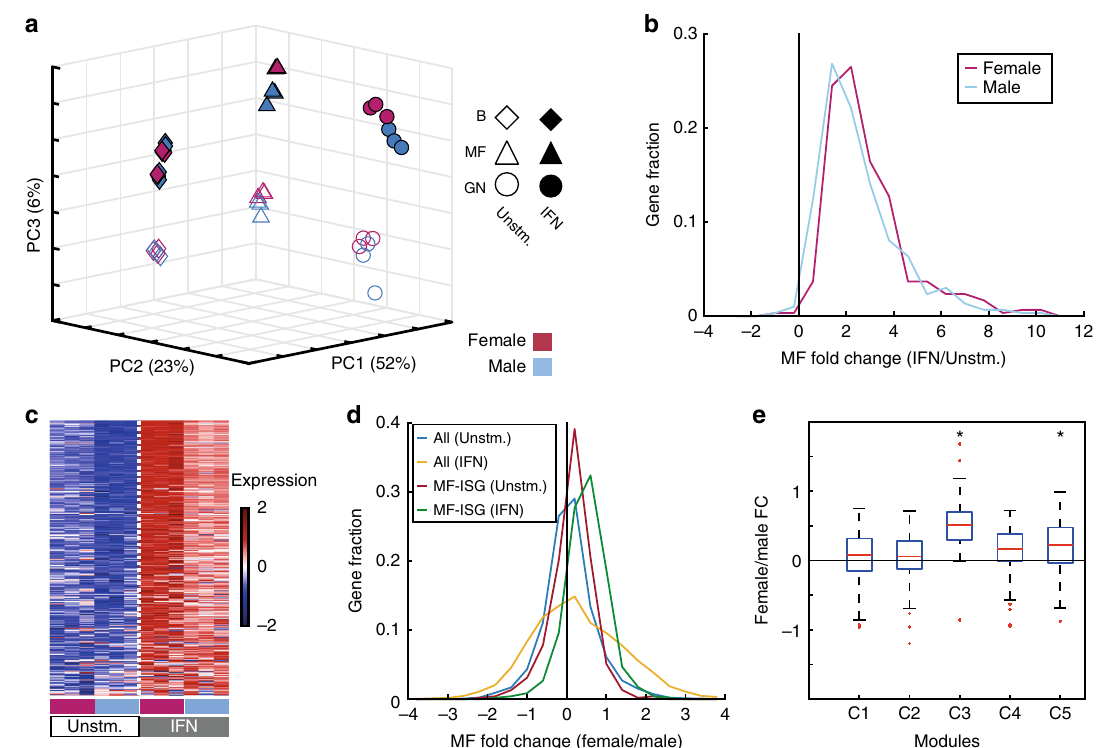
Fig. 4 Interferon boosts the transcriptional sexually differential immune response. a Principal component analysis (PCA) of GN, MF, and B cells (circles, triangles, and diamonds, respectively) of females and males (pink and light blue) with and without IFN ( fi lled or open shapes, respectively), based on 1000 autosomal genes with the highest standard deviation. Axes are the fi rst three principal components (PCs). b The distribution of the log 2 fold change values between IFN-stimulated MF and unstimulated MF for the IFN upregulated genes in male and/or female MF. Distribution for female samples is shown in pink and for male in light blue. The t test p value between distributions is 2.7 × 10 − 13 with permutation p value <0.001. c Expression heatmap of 313 MF IFN-stimulated genes (MF-ISGs) expressed in unstimulated and IFN-stimulated male and female macrophage samples (dataset B). Expression values are trimmed to range [ − 2, 2]. Dotted vertical white line separate IFN-stimulated and unstimulated samples. d Female – male fold change distribution of MF- ISGs and all remaining genes from unstimulated samples (red and light blue, respectively) and MF-ISGs and all remainder genes from IFN-stimulated samples (green and yellow, respectively). e Box plot presenting female – male log 2 fold change (FC) distribution of the genes in modules C1 – C5 de fi ned by Mostafavi et al. 35 from IFN-stimulated macrophages. On each box, the central mark indicates the median, and the bottom and top edges of the box indicate the 25th and 75th percentiles, respectively. The whiskers extend to the most extreme data points not considered outliers, and the outliers are plotted individually in red. Unstm unstimulated, IFN interferon. Modules whose distributions are signi fi cantly different from zero (one-sample two-sided t test pFDR < 0.05) are marked by asterisk. Source data for a – e are provided as a Source Data fi